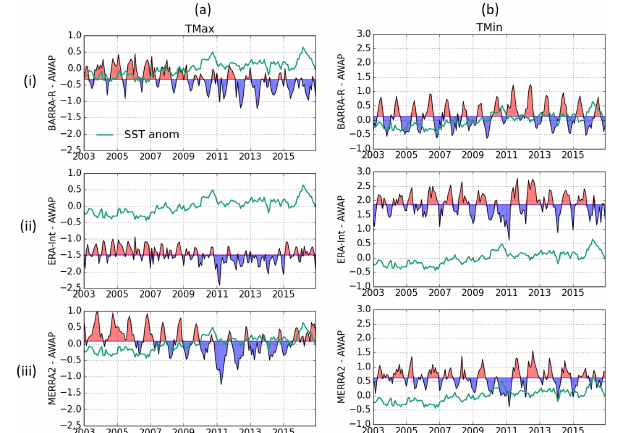
Figure 6. Monthly mean differences in daily (a) maximum (TMax) and (b) minimum (TMin) 2m temperature (K) averaged over Aus- tralia between (row i) BARRA-R and AWAP, (ii) ERA-Interim and AWAP, and (iii) MERRA-2 and AWAP. Black curves are shaded around the 14-year means. Green curves plot the monthly anoma- lies, from 2003–2016 monthly averages, of the OSTIA sea surface temperature averaged over 46–4 ◦ S and 94–174 ◦